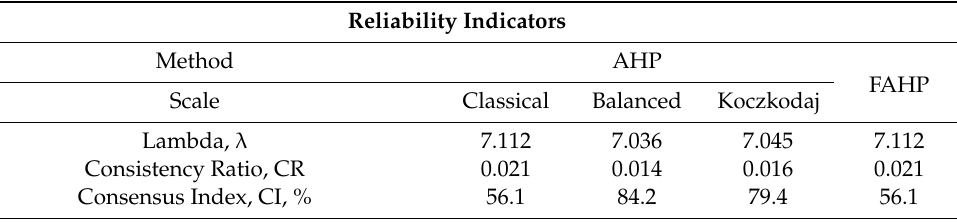
Table 2. Detailed results of experts’